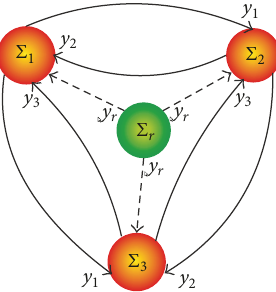
Figure 1: A connection graph. Example of full chain interconnec- tion